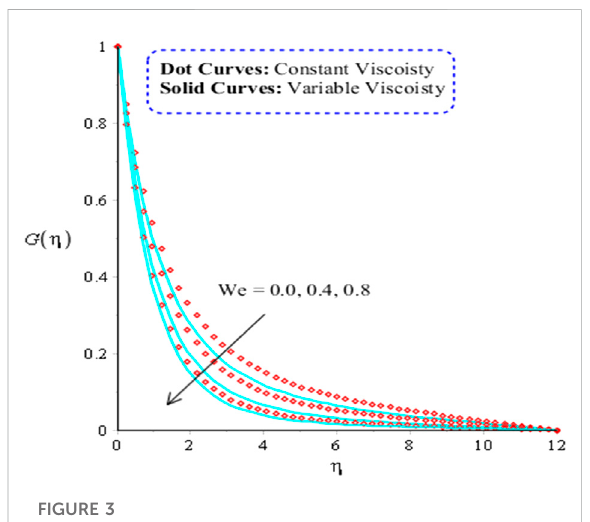
FIGURE 5 Variation in secondary velocity fi eld versus β i .